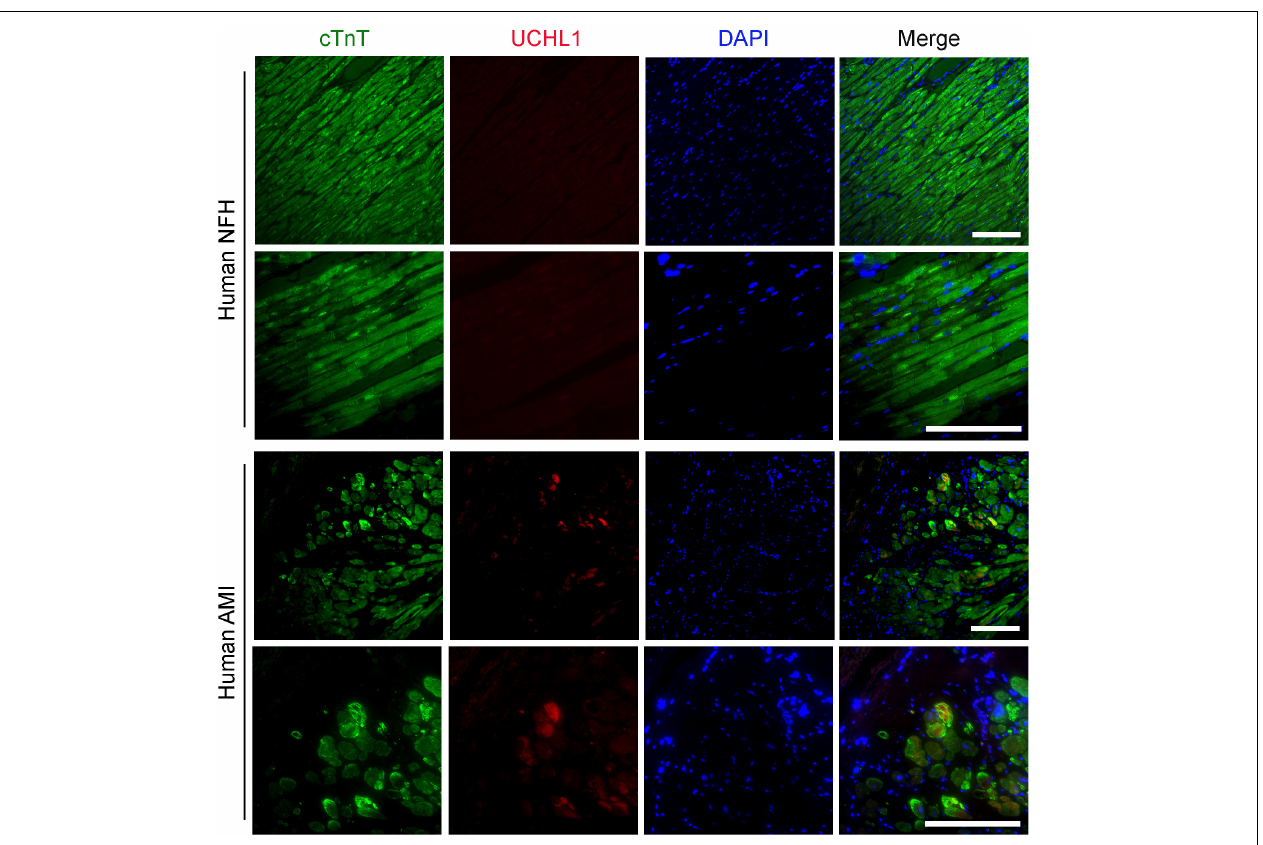
FIGURE 3 | Post-MI myocardial upregulation of UCHL1 occurred primarily in the cardiomyocytes of the peri-infarct zone in humans. Paraffin-embedded and formalin-fixed ventricular myocardial sections (4- µ m thick) from human non-failing donor hearts (NFH) or from the tissue cylinder core obtained from acute myocardial infarction (AMI) patients during the installation of a LV assisting device were subjected to deparaffinization, rehydration, antigen recovery, and indirect immunofluorescence staining for cardiac troponin T (cTnT) to identify cardiomyocytes (green) and for UCHL1 (red) as described in the Methods section. Nuclei are counter-stained with DAPI (blue). Shown are the representative confocal images. Scale bar, 100 µ